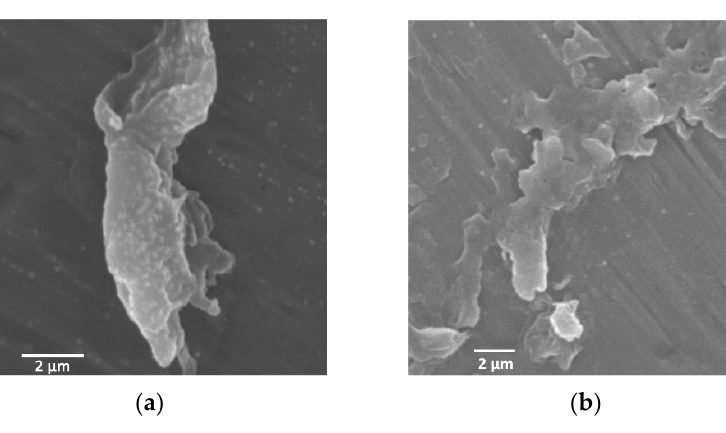
Figure 3. SEM images of ( a ) 1 /[Ag(CN) 2 ] − , ( b ) 2 /[Ag(CN) 2 ] − , and ( c ) 3 /[Ag(CN) 2 ] − , where [Ag(CN) 2 ] − = 5.0 mM.